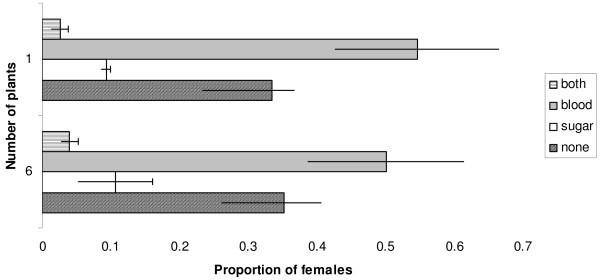
The proportions ± SEM of females that fed on blood, sugar, both, or neither, when one or six Senna didymobotrya were present. All replicates are combined.